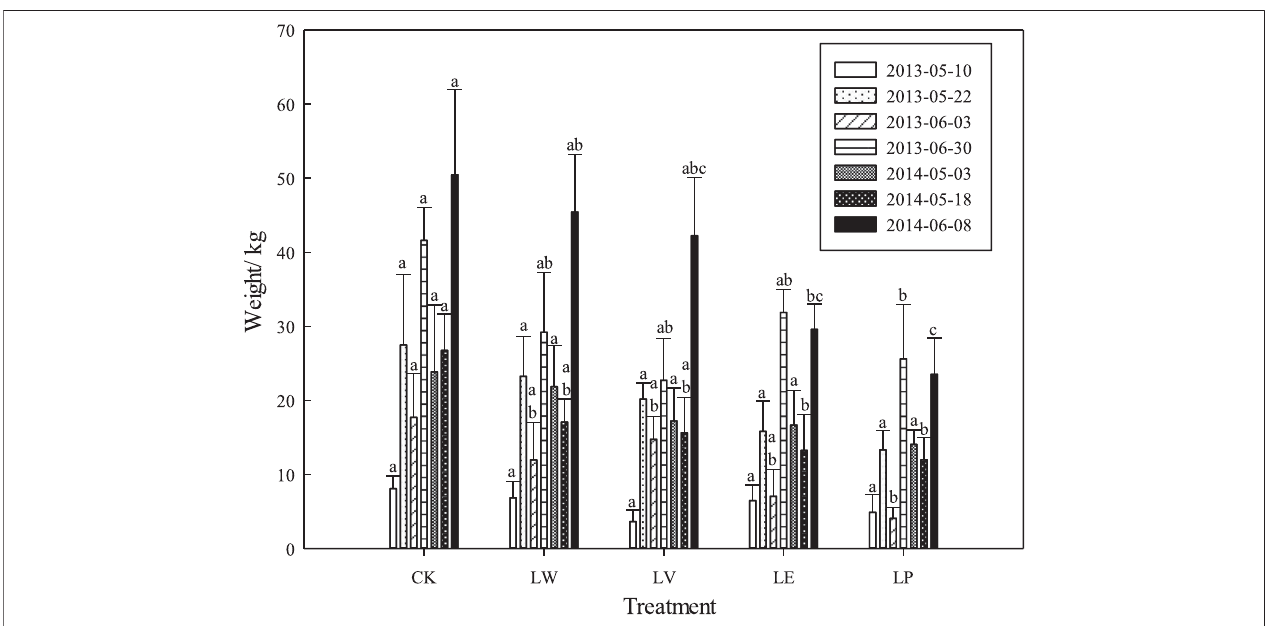
FIGURE 1 | Cumulative runoff of single rainfall for different treatments in 2013 and 2014(CK, untreated soil; LW, lime + Setaria lutescens ; LE, lime + Elsholtzia splendens ; LV, lime + Vetiveria zizanioides ; LP, lime + Pennisetum sp ., Different lowercase letters indicate signi fi cant differences between treatments, n (cid:2) 3, p < 0.05).